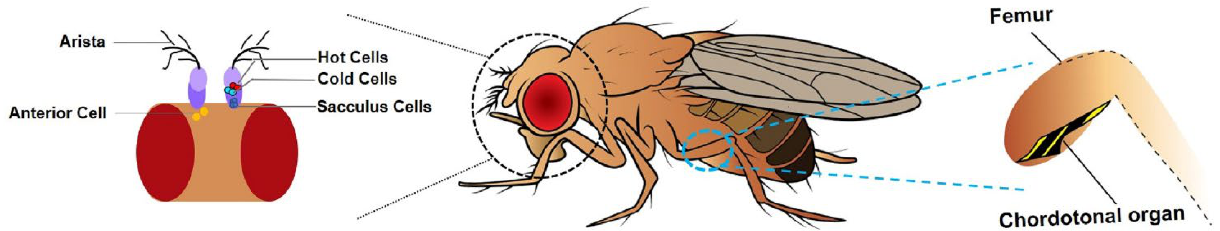
Figure 1. Schematic of the anatomy of thermoreception in Drosophila . Left: Hot cells (red) and cold cells (blue) that sense heat and cold are present peripherally in the arista. The Sacculus cells (dark blue) are located in a pouch called the Sacculus within the antennal segments (light and dark purple). Anterior cells (yellow) are found inside the brain, near the antennae. Right: The chordotonal organ (yellow-black stripes) is located at the root of the Drosophila leg.